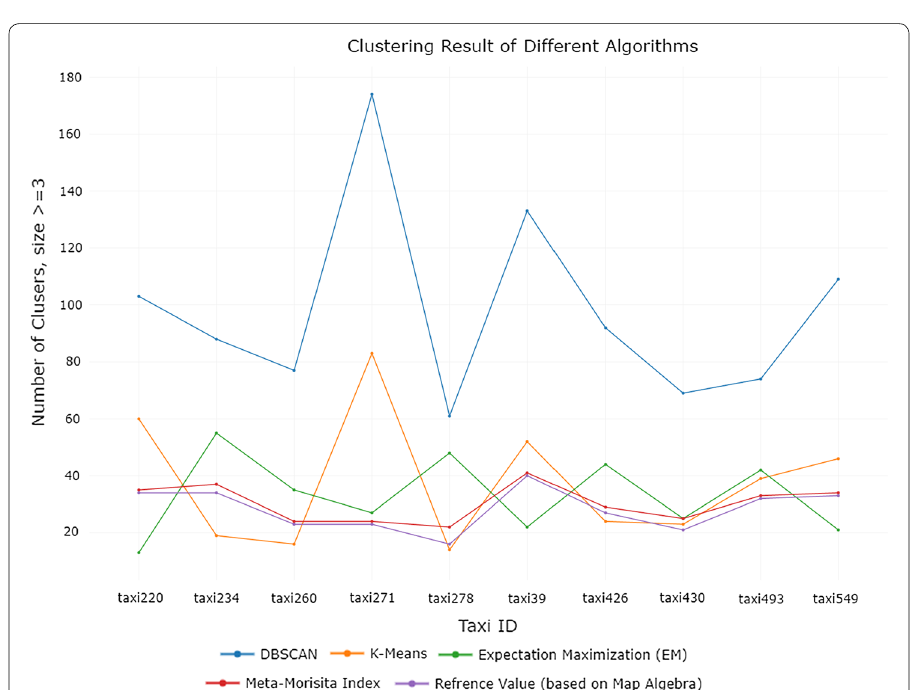
Fig. 21 The number of the clusters being detected by meta-Morisita index, K-means clustering, DBSCAN and EM Clustering algorithm. The size of the cluster is great or equal to